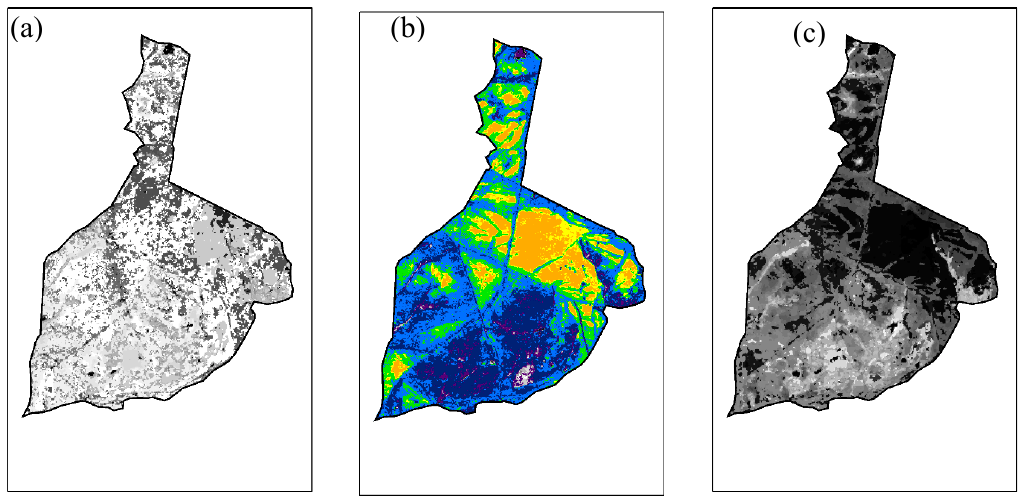
Figure 4. Spatial expression of pre-fire canopy classes, fire severity, and post-fire canopy classes. ( a ) pre-fire 20-class ALS CHP data. ( b ) severity classification. ( c ) post-fire 20-class ALS CHP data.